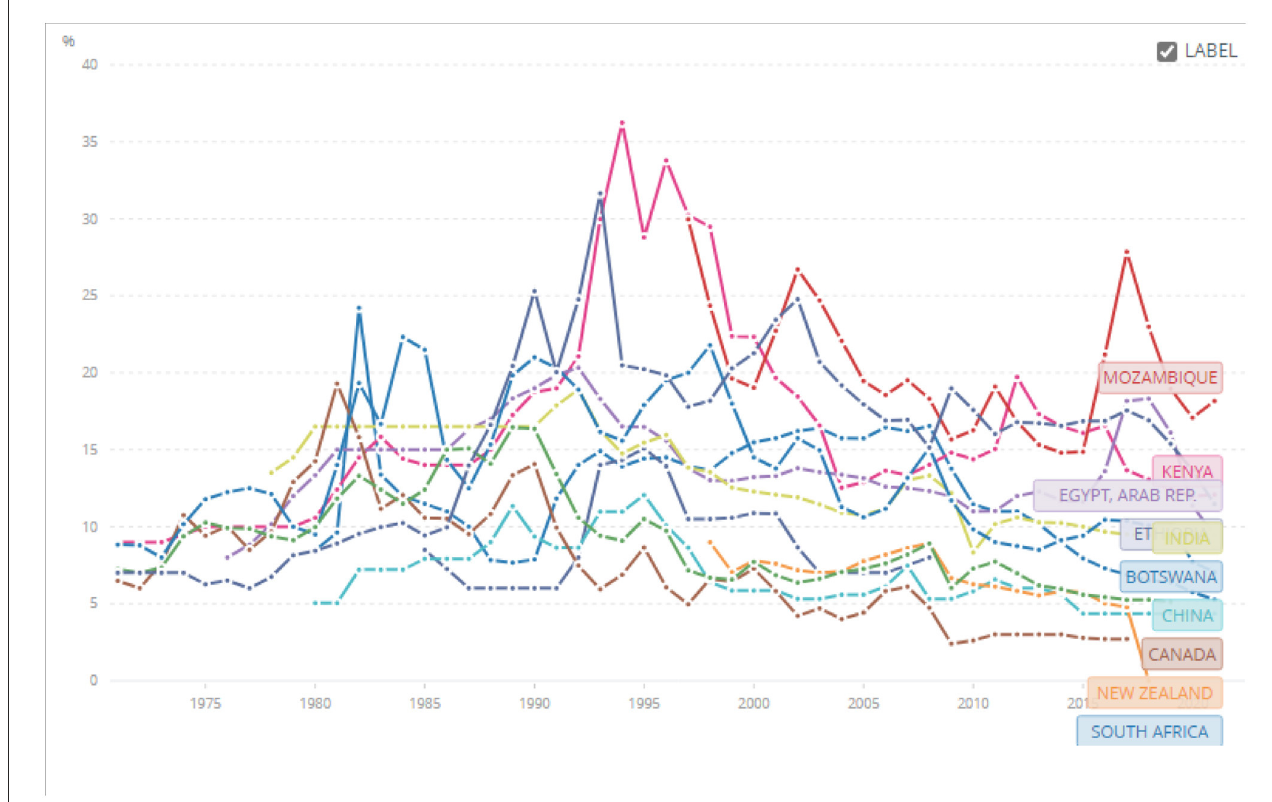
FIGURE3 Lending rates (%) from 1971 to 2021 for Australia, Botswana, Ghana, Ethiopia, Kenya, China, Egypt, India, Mozambique, Canada, New Zealand, and South Africa. Source: World Bank Data: https://data.worldbank.org/indicator/FR.INR.LEND?end=2021&locations=BW-GH-ET-KE-CN-EG-IN-MZ-CA-NZ-ZA-